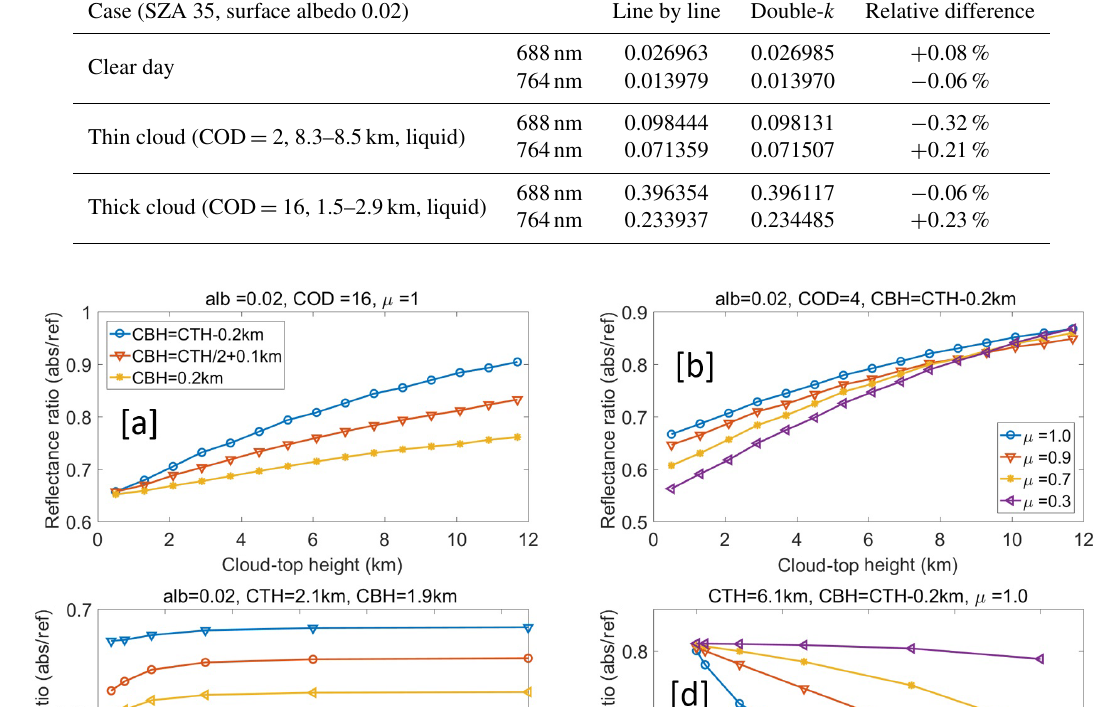
Table 1. Comparison of simulated narrowband measurement at EPIC A- and B-band channels. Case (SZA 35, surface albedo 0 . 02)